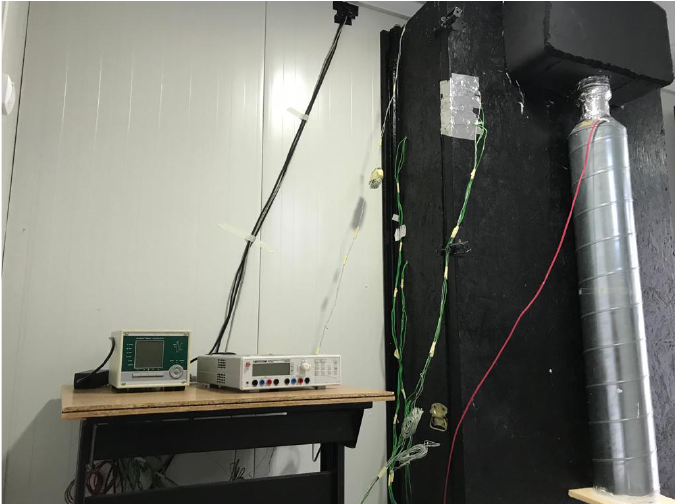
Figure 8. Installation of the data logger and the fan power supply in the container.